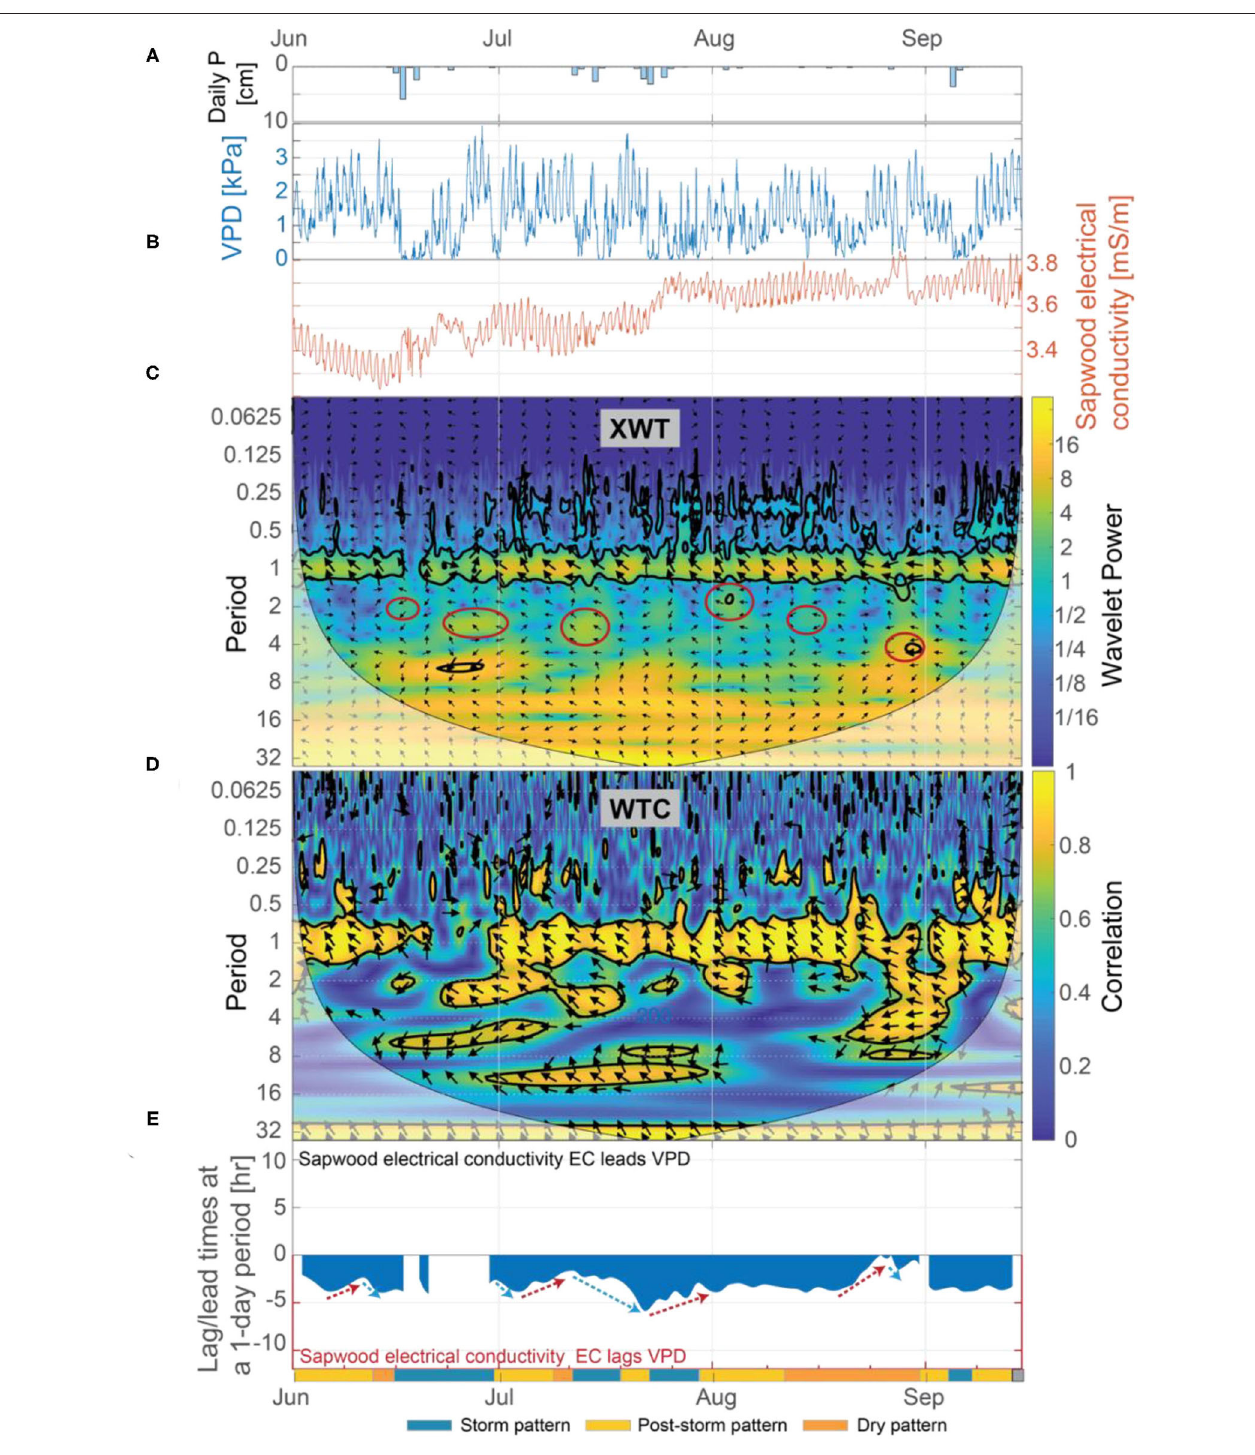
FIGURE 9 | (A) Daily precipitation, (B) vapor pressure deficit (VPD) and inverted sapwood conductivity, (C) the XWT of VPD and inverted sapwood electrical conductivity, (D) the WTC of VPD and inverted sapwood electrical conductivity, and (E) the lag time between VPD and inverted sapwood electrical conductivity. Regions in time-frequency space in the XWT that had moderately high wavelet power, had periods > 1-day, and where the WTC identified high correlation are outlined with red circles. The regions outlined with red circles coincide with the storm events. Red arrows in (E) highlight periods when we hypothesize that progressively dryer conditions increased stomatal regulation, and subsequently decreased lag times. Blue arrows in (E) highlight periods when we hypothesize that increased moisture, due to precipitation, decreased stomatal regulation, and subsequently increasing lag times.